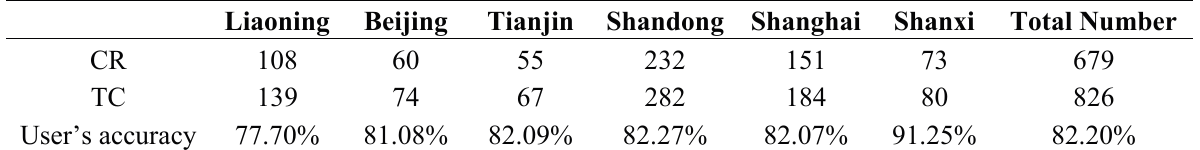
Table 6. User’s accuracy of artificial surfaces in